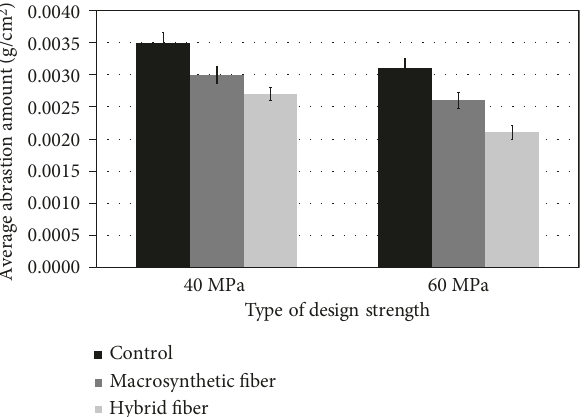
Figure 21: Abrasion resistance of optimum mix